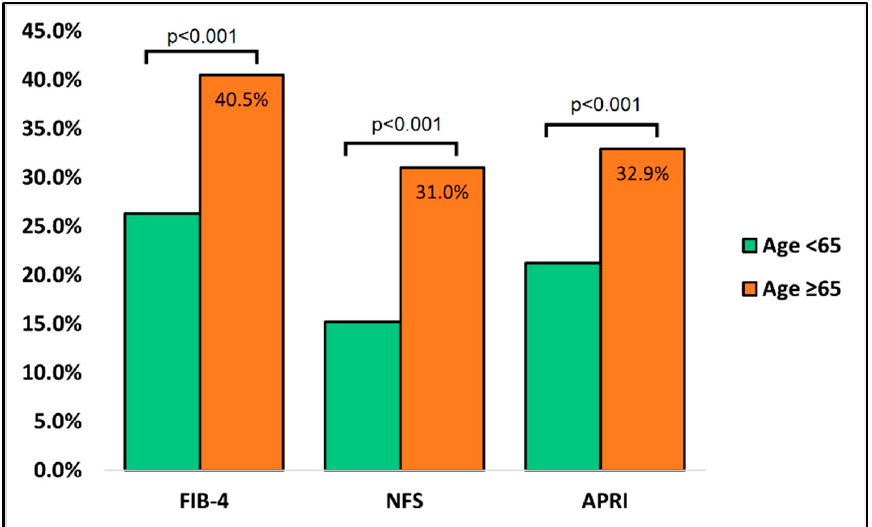
Figure 1. Comparison of liver fibrosis scores between cases and controls at admission. Table 4. Comparison of liver studies at discharge between cases and